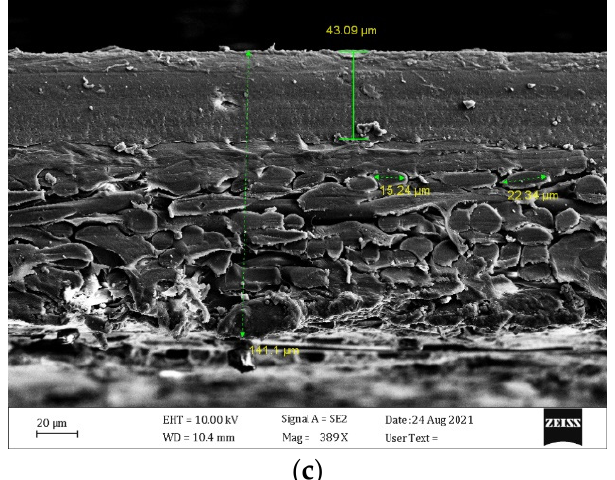
Figure 3. FESEM micrographs of the cross-section of ( a ) kraft paper, ( b ) P-MEM, and ( c ) C-MEM.